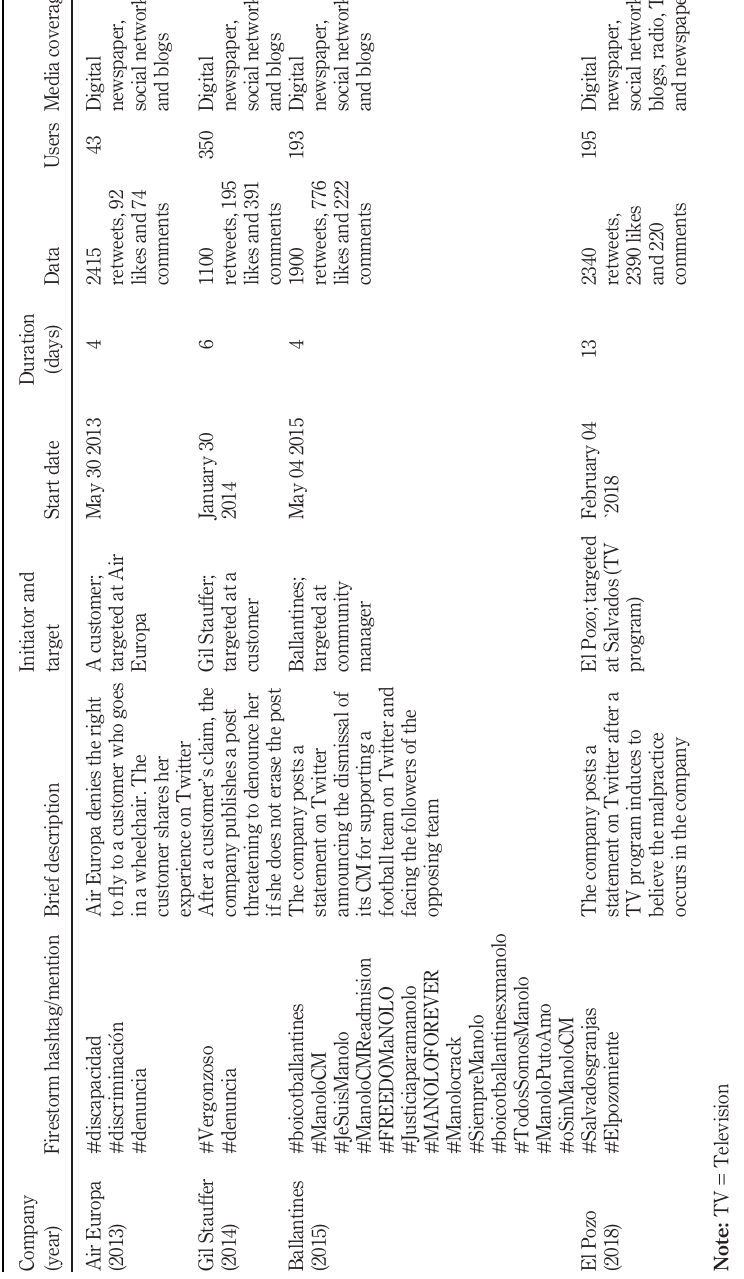
Table II. Overview of the OFs